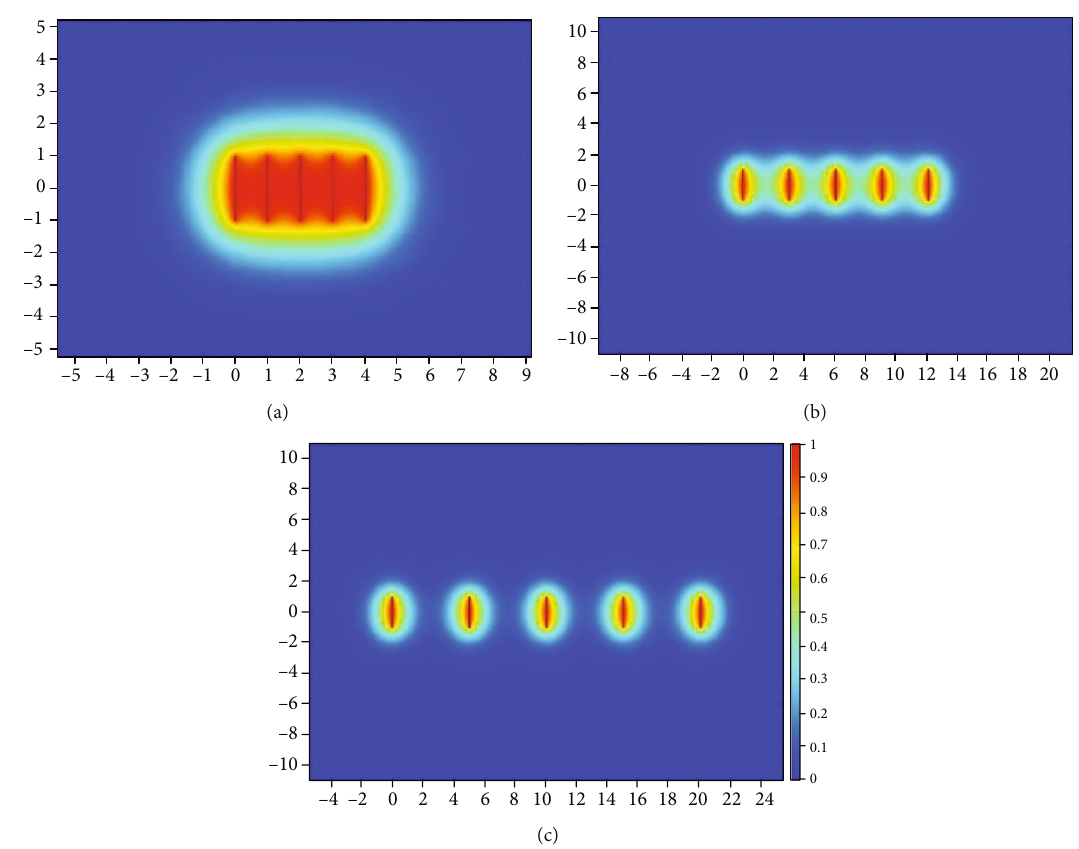
t D = 1 , D = 1 ; (b) case2